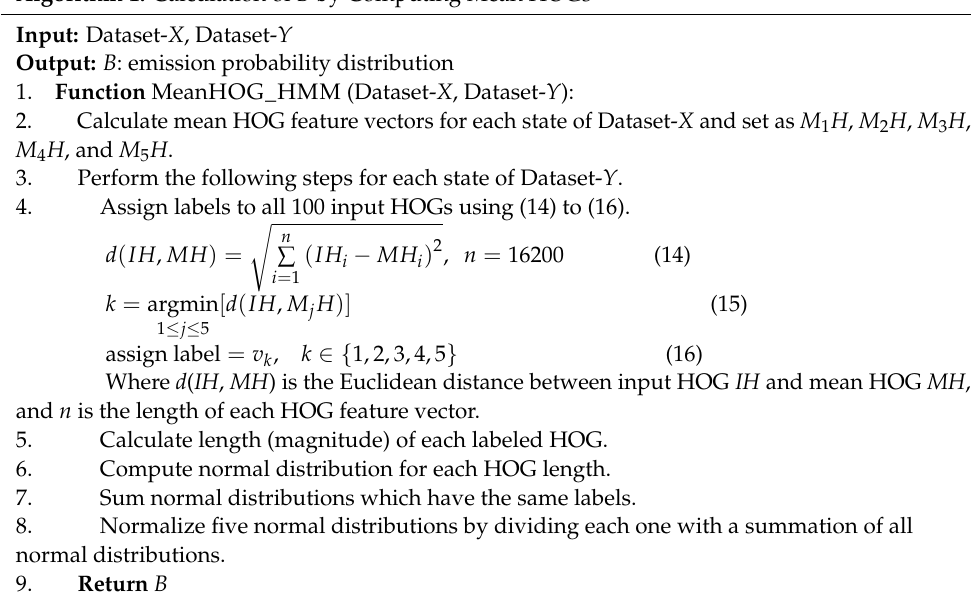
Algorithm 1. Calculation of B by Computing Mean